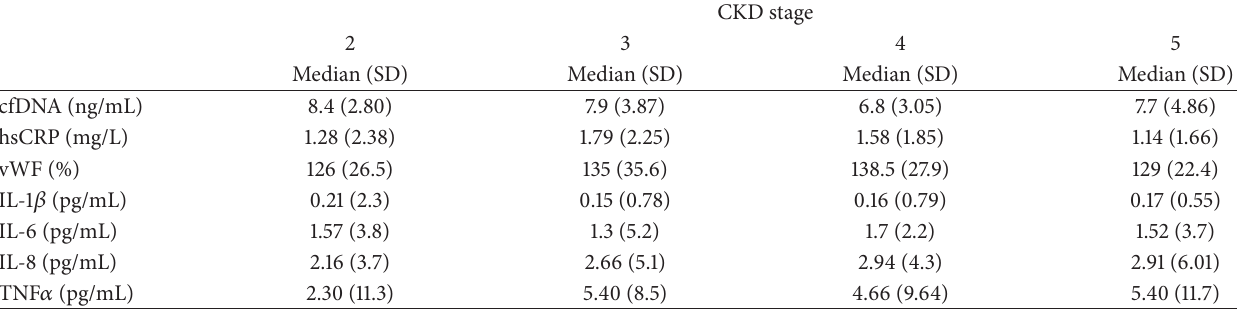
Table 1: Baseline characteristics of the study population by CKD